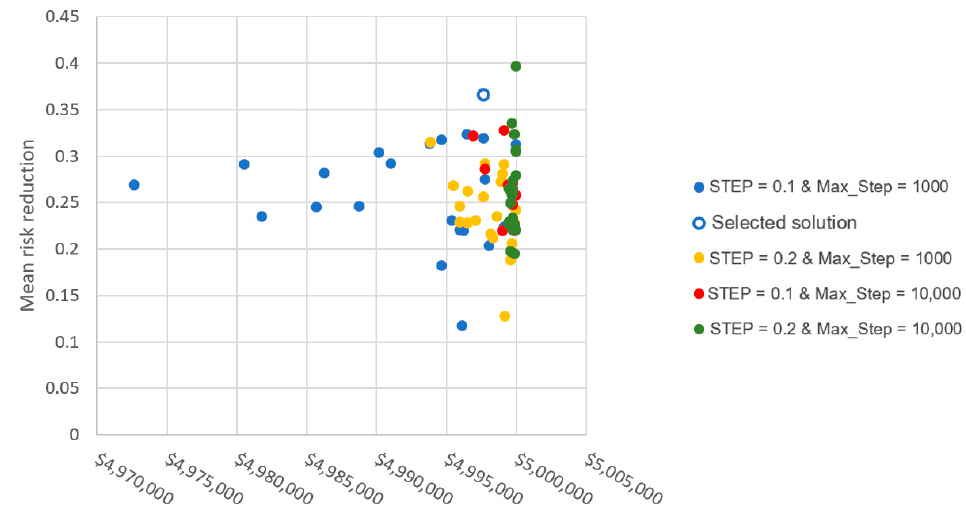
Figure 8. Variation in solution space for maximum risk reduction for a budget of $5,000,000 for varying global parameter Max steps and intervention increment step size.